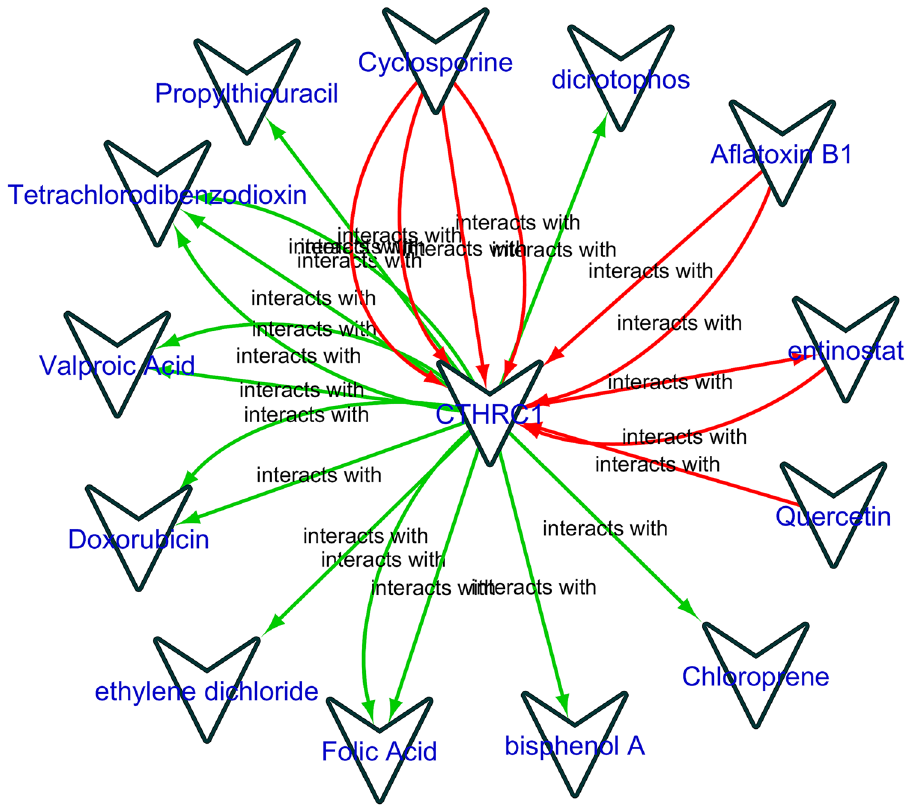
Figure 16. Gene–drug interaction network of the CTHRC1 and chemotherapeutic drugs. Red arrows: chemotherapeutic drugs increase the expression of CTHRC1; green arrows: chemotherapeutic drugs decrease the expression of CTHRC1. The numbers of arrows between chemotherapeutic drugs and key genes in this network represent the supported numbers of literatures by previous